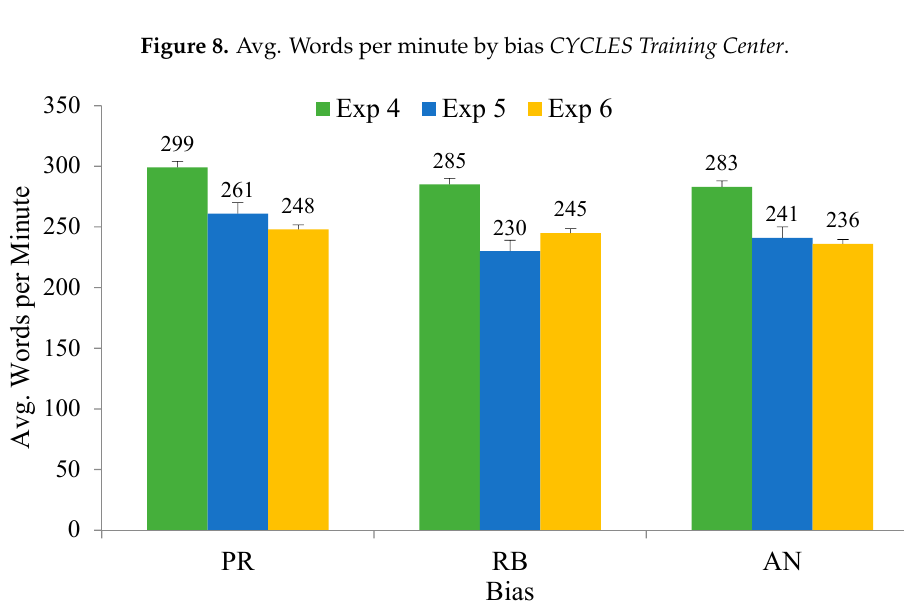
Figure 9. Average words per minute by bias CYCLES Carnivale .